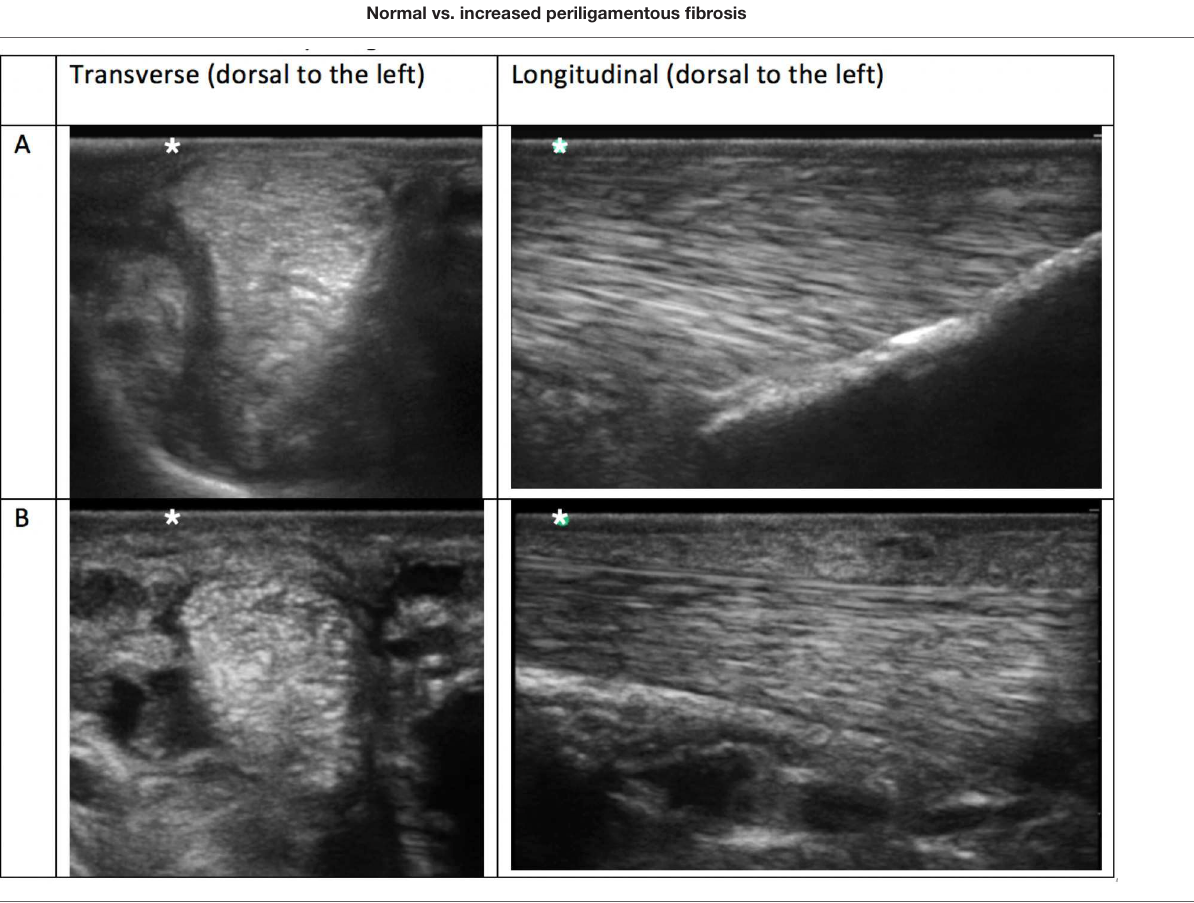
TABLE 4 | Comparison ultrasonograms taken from a population of elite level showjumping Warmbloods having no recent history or clinical signs of suspensory ligament branch (SLB) injury. Normal vs. increased periligamentous